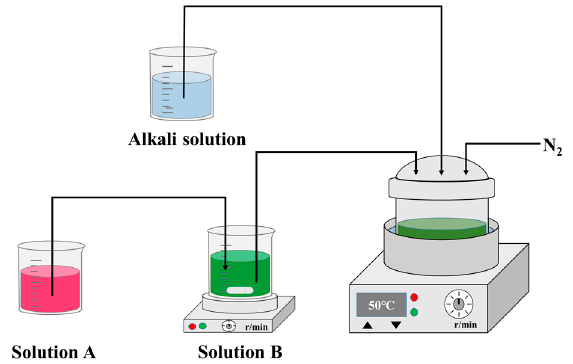
Figure 9. Schematic illustration of the preparation of concentration-gradient precursor Ni 0.9 Co 0.083 Mn 0.017 (OH) 2 .